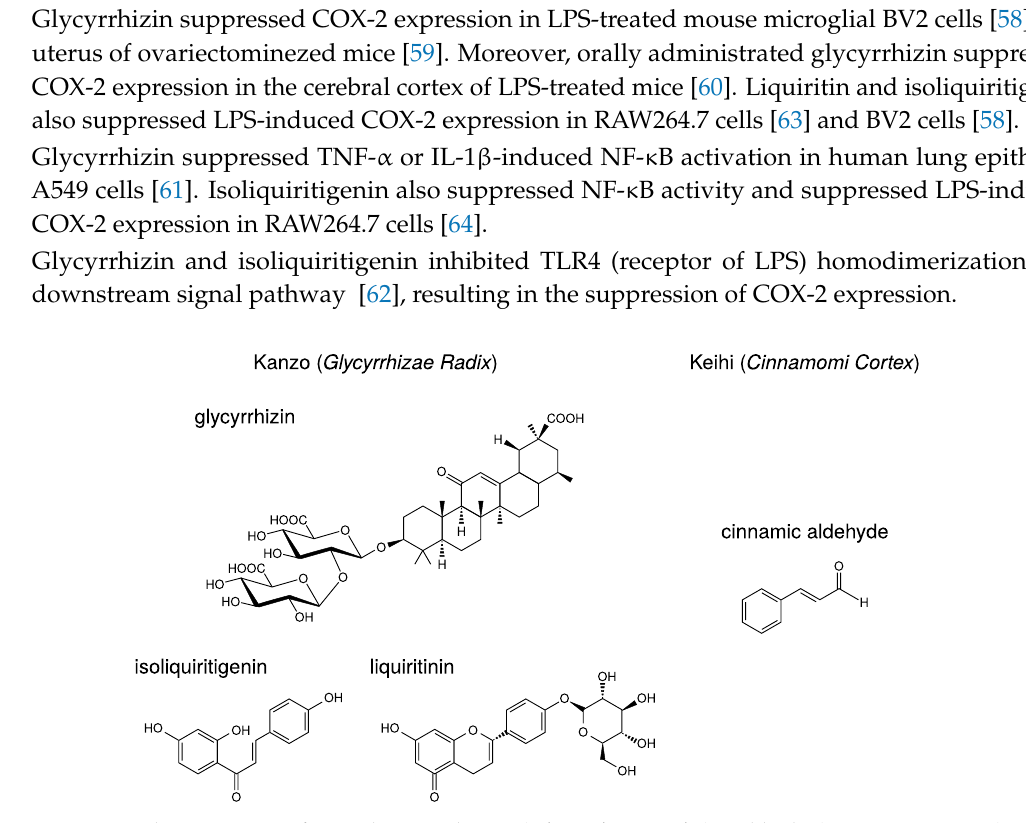
Figure 6. The structures of ingredients in kanzo ( Glycyrrhizae Radix ) and keihi ( Cinnamomi Cortex